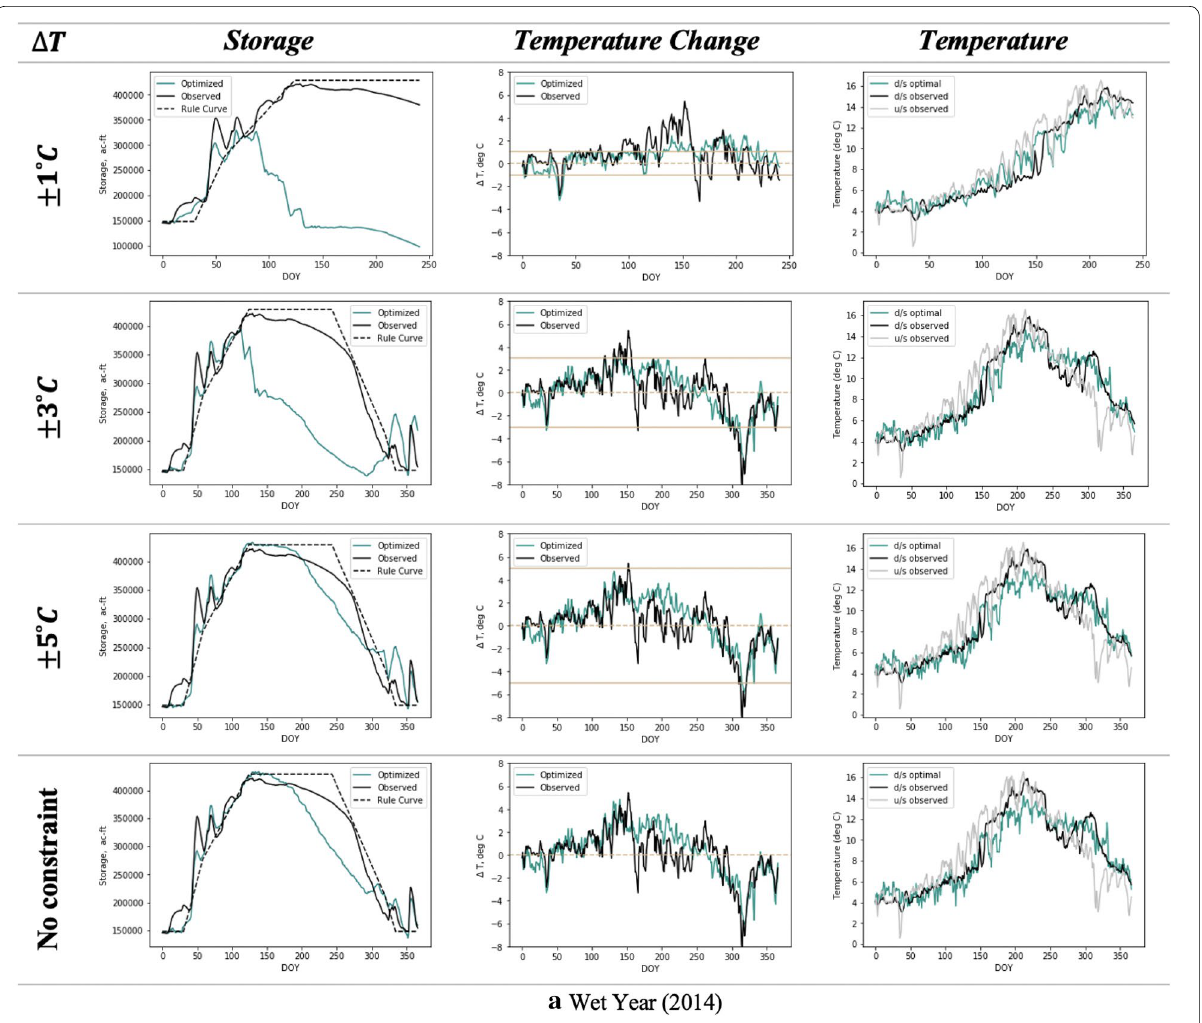
Fig. 11 a Optimal reservoir states and downstream temperatures for different allowable temperature change scenarios over wet (high flow) year. Optimal downstream temperatures (third column) are derived from the respective optimal temperature changes (second column). b Same as Fig. 10a, but for dry (low flow) year of